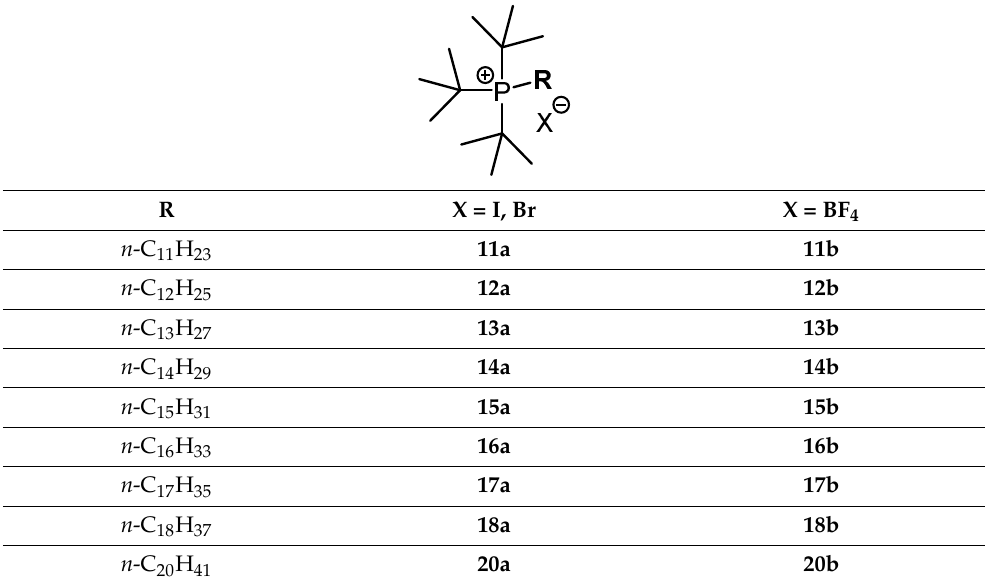
Table 1. Cont. Table 1. The structure of the QPSs under investigation.